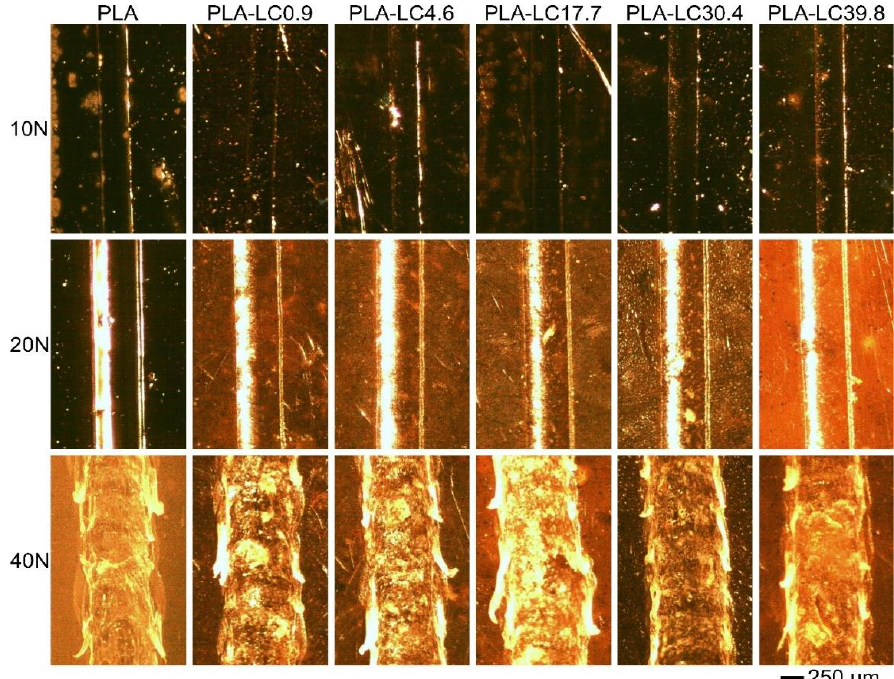
Figure 3. Microscopic images of scratches created on the samples during the scratch resistance evaluation.